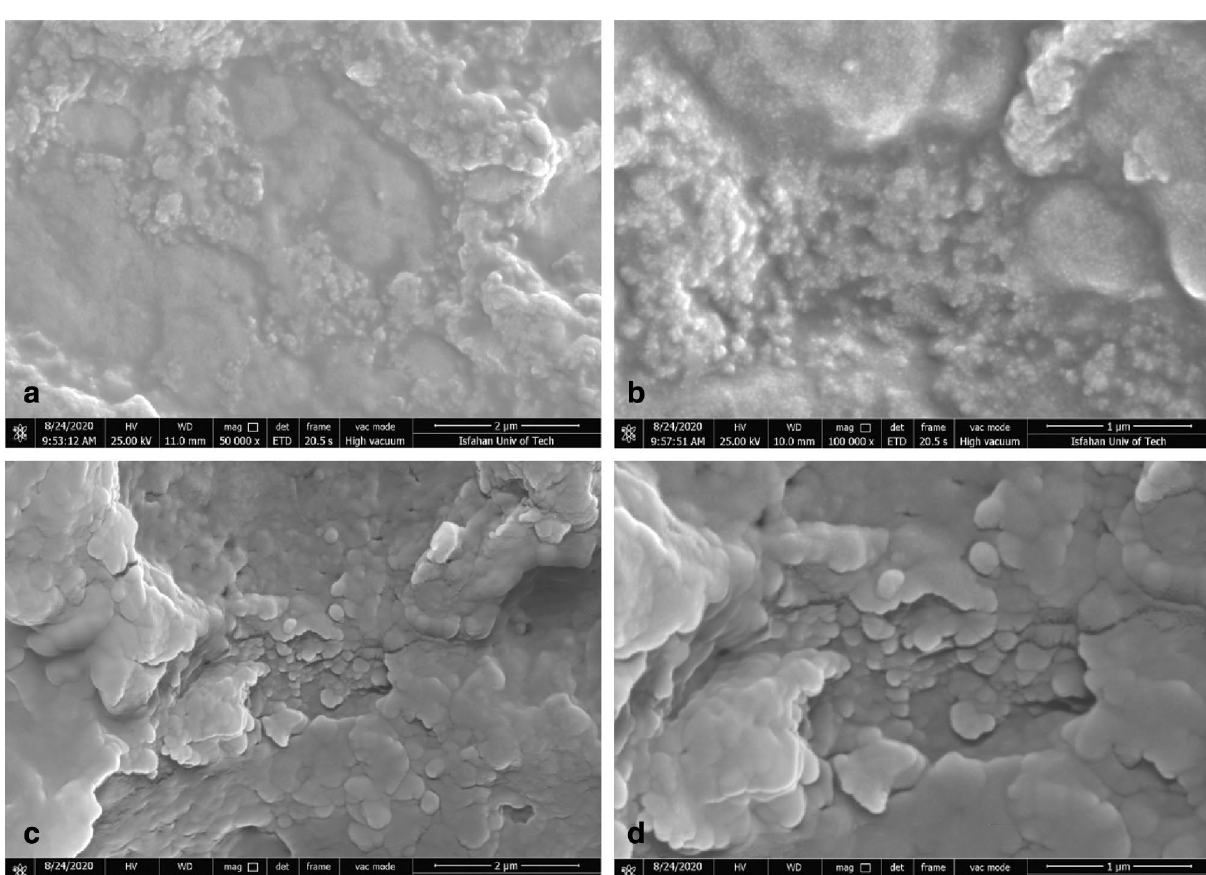
Figure 2. FESEM image of: ( a ) bee carcasses/polyaniline composite with 50000X magnification, ( b ) bee carcasses/polyaniline composite with 100,000 X magnification, ( c ) bee carcasses/polyaniline/polyethylene glycol composite with 50,000 X magnification, ( d ) FESEM images of bee carcasses/polyaniline/polyethylene glycol composite with 100,000 X